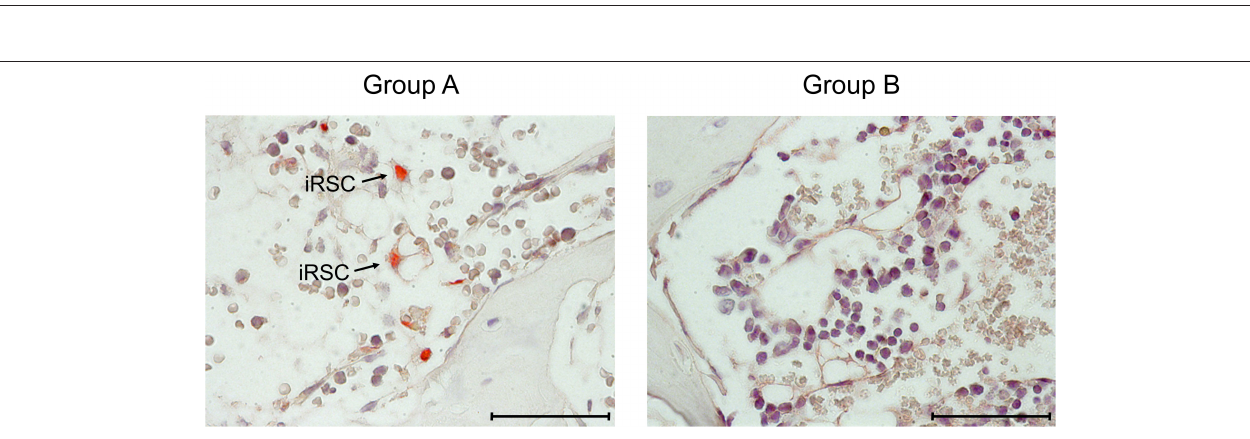
BM stroma of group B recipients after CTL transfer. Evidently, in this “therapy group,” the bone marrow was in a stage of ongoing